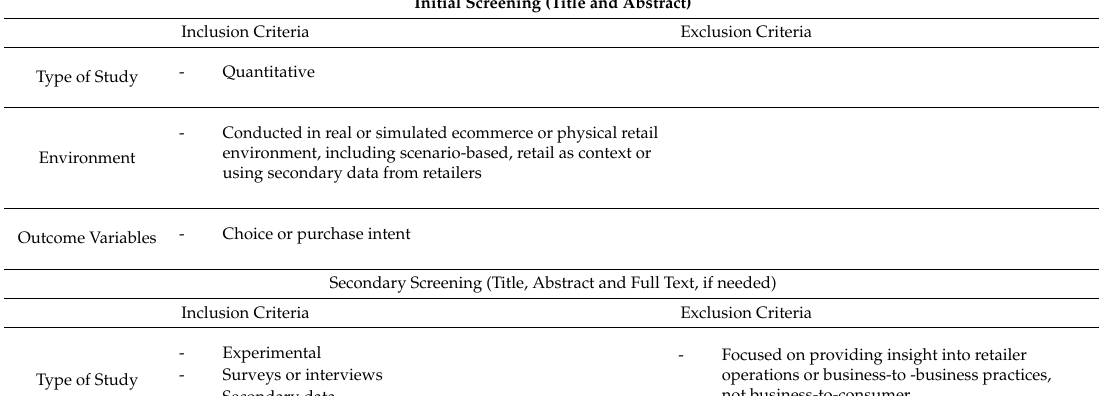
Table 1. Inclusion and exclusion criteria for each round of